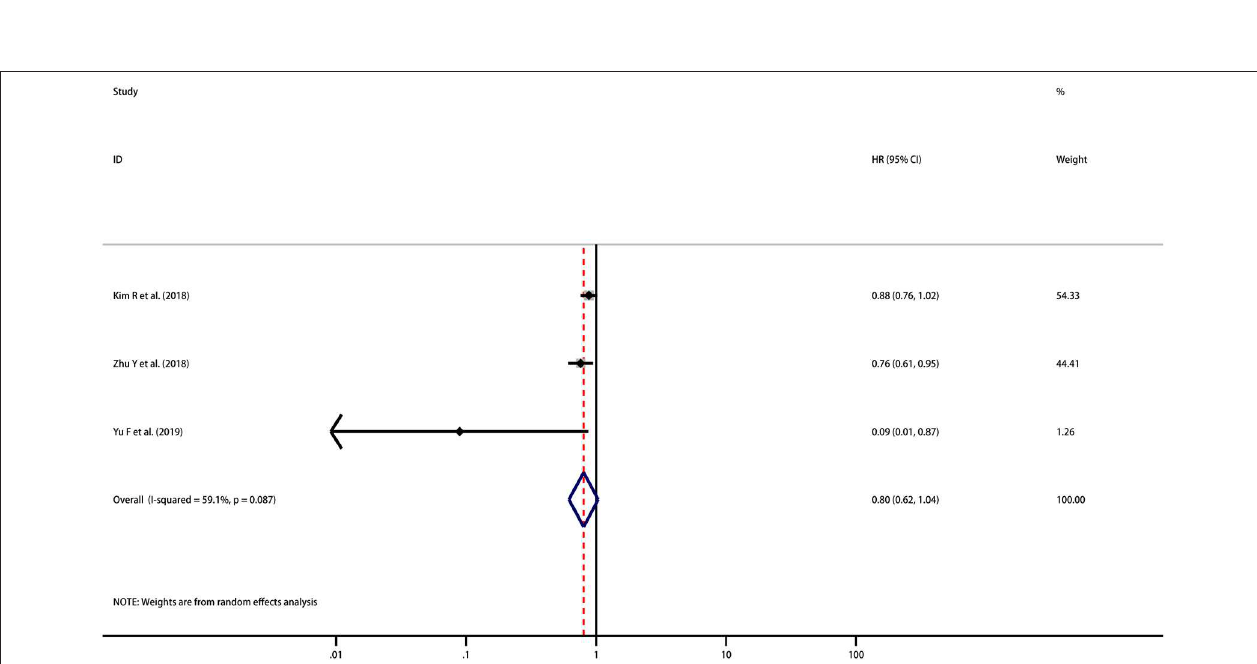
FIGURE 3 | Meta-analysis of the correlation between PD-L1 expression in TCs and DFS among patients with CCA.